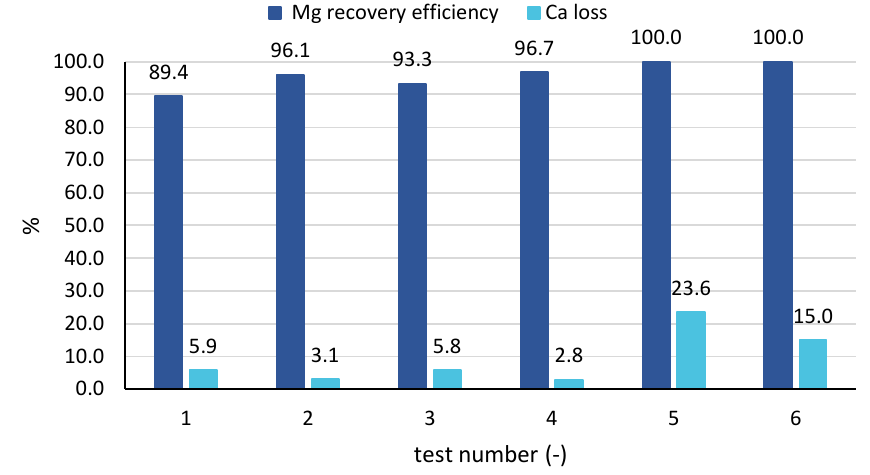
Figure 7. Averaged values of magnesium recovery efficiency and calcium loss in all tests 1–6.